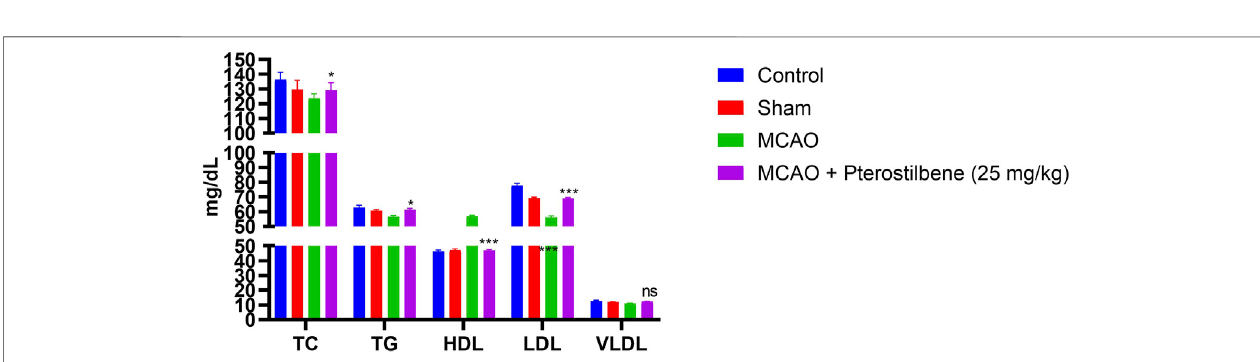
FIGURE 8 | showed the lipid parameters of among experimental groups. Values are expressed as mean ± SEM. The t -test was used for the signi fi cant difference between groups: * p < 0.05, ** p < 0.01, *** p < 0.005. NS, non-signi fi cant.